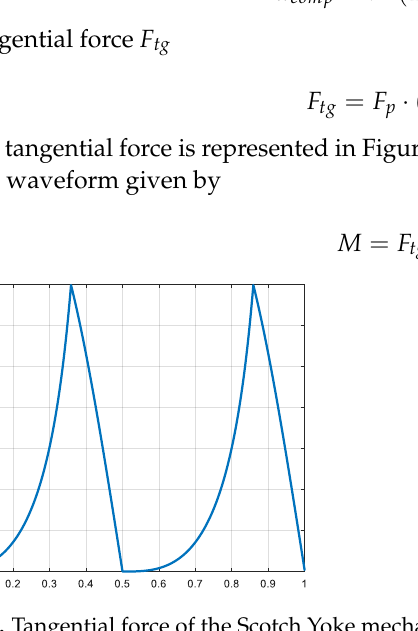
Figure 13. Definition of variables of the Scotch Yoke mechanism.